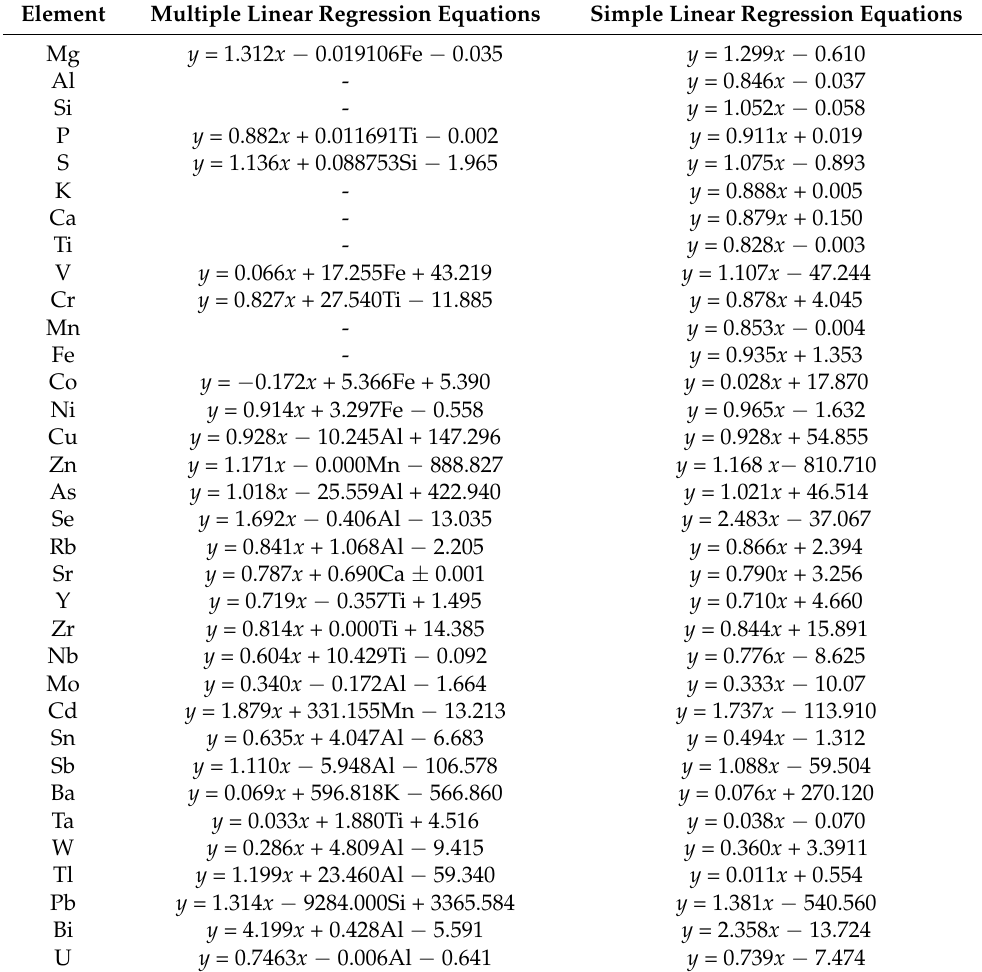
Table 3. Correction equations for elements detected by pXRF